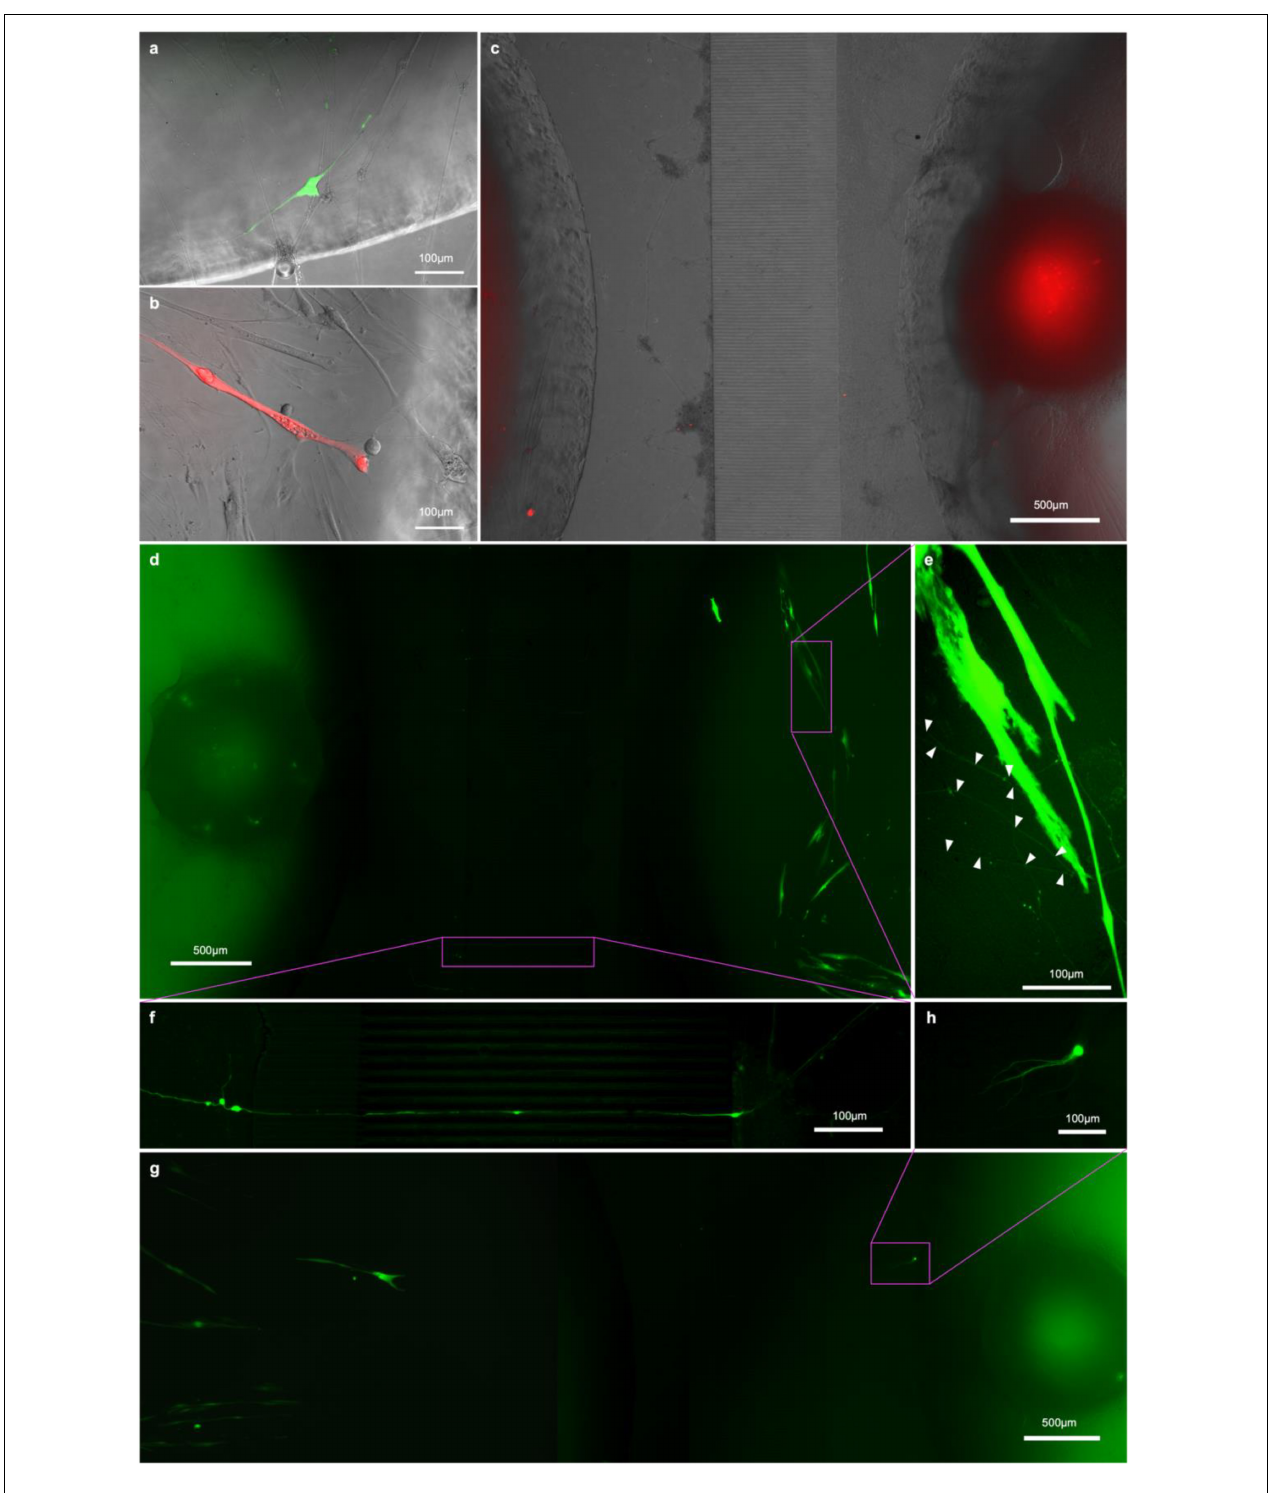
FIGURE 8 | RV-infection and retrograde tracing. (a) EnvA- (cid:49) G-RV-GFP and (b) EnvA- (cid:49) G-RV-mCherry-infected myotube fluorescence 48 h after infection superimposed on phase-contrast images of the respective myotubes; (c,d,g) overview tracing EnvA- (cid:49) G-RV-mCherry fluorescence superimposed on phase-contrast image at 31 DIV (c) and EnvA- (cid:49) G-RV-GFP (d,g) from infected myotubes to cell bodies inside the aggregates (d) and cells that migrated out (g,h) at 29 DIV; (e) details of axons connecting up the infected myotubes and (f) crossing the channels from the outer to the myotube compartment.